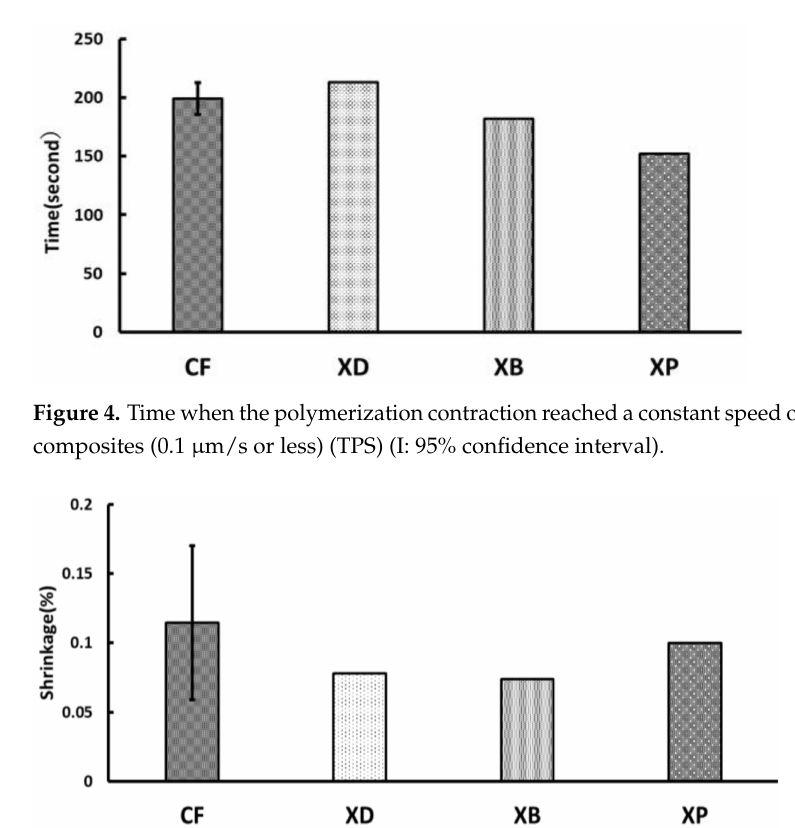
Figure 5. Amount of polymerization shrinkage rate after polymerization shrinkage reaches a constant speed of short fiber reinforced composites (0.1 µ m/s or less) (PSA) (I: 95% confidence